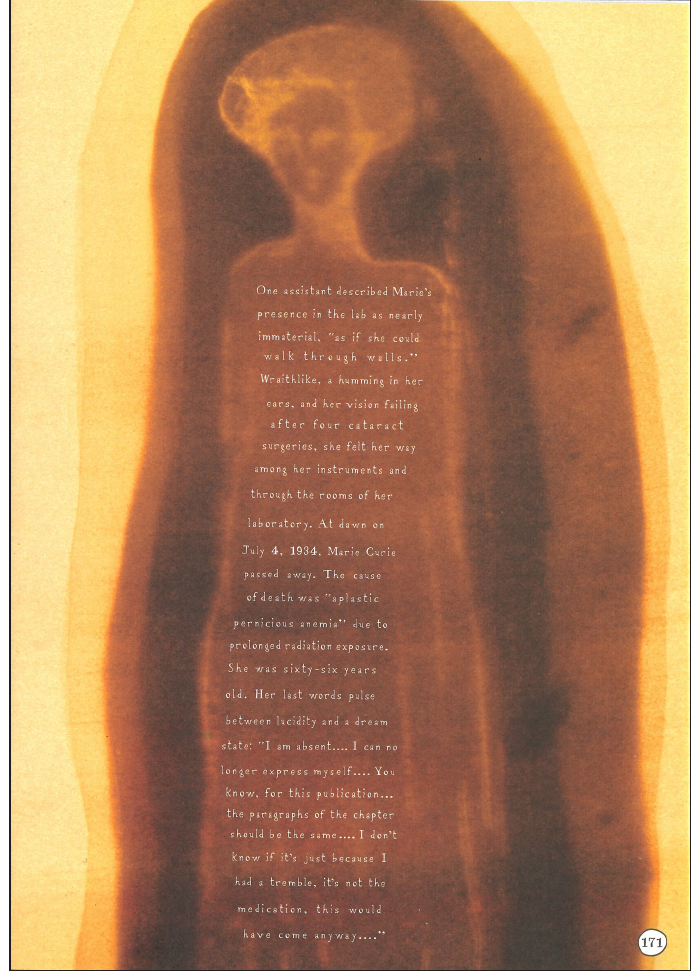
Figure 3: Marie’s Death in Radioactive by Lauren Redniss, 2010: 171. © It Books/ HarperCollins – Lauren